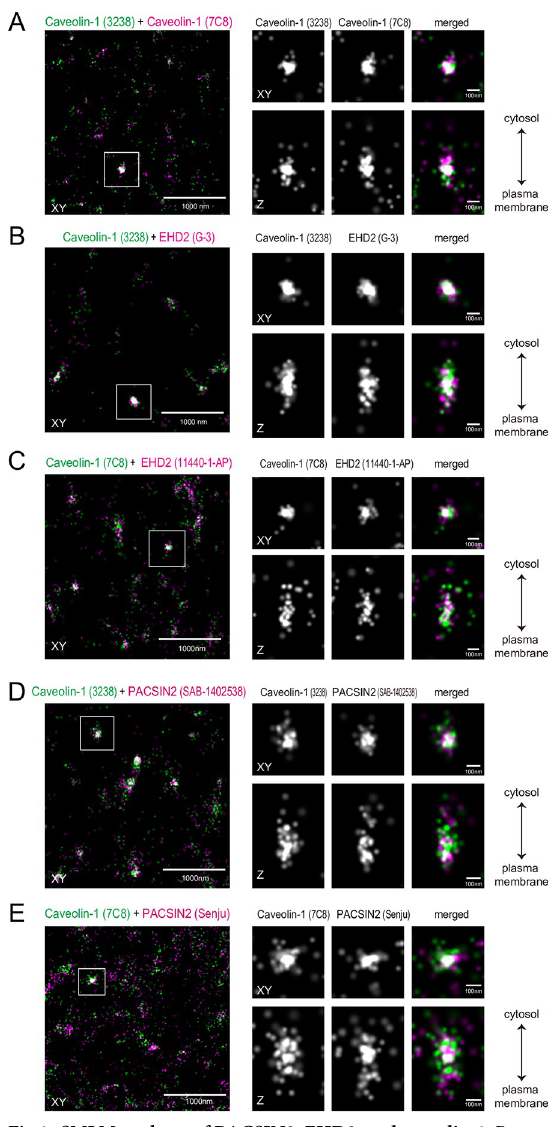
Fig 1. SMLM analyses of PACSIN2, EHD2, and caveolin-1. Representative reconstituted image of caveolin-1 (green) with those of PACSIN2 or EHD2 (magenta) in HeLa cells. The merged image of the focal plane (XY) is shown on the left. The box indicates the region for the enlarged images on the right, and contains one blob composed of caveolin-1 presumably corresponding to a caveola, with the projection to show the signal distribution to the Z-direction for each caveolin-1, PACSIN2, or EHD2 image. The combinations of antibodies are: (A) Caveolin-1 (7C8) + Caveolin-1 (3238), (B) Caveolin-1 (3238) + EHD2 (G-3), (C) Caveolin-1 (7C8) + EHD2 (11440-1-AP), (D) Caveolin-1 (3238) + PACSIN2 (SAB-1402538), and (E) Caveolin-1 (7C8) + PACSIN2 (Senju).